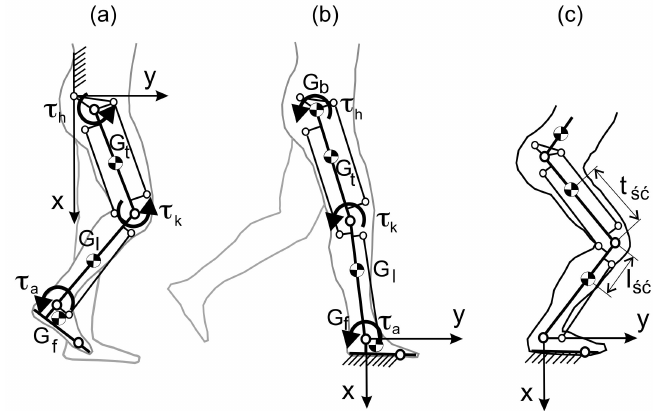
Figure 3. Hydraulic exoskeleton model of the lower limb in the sagittal plane in the transfer phase ( a ), in the support phase ( b ), and in the squat phase ( c